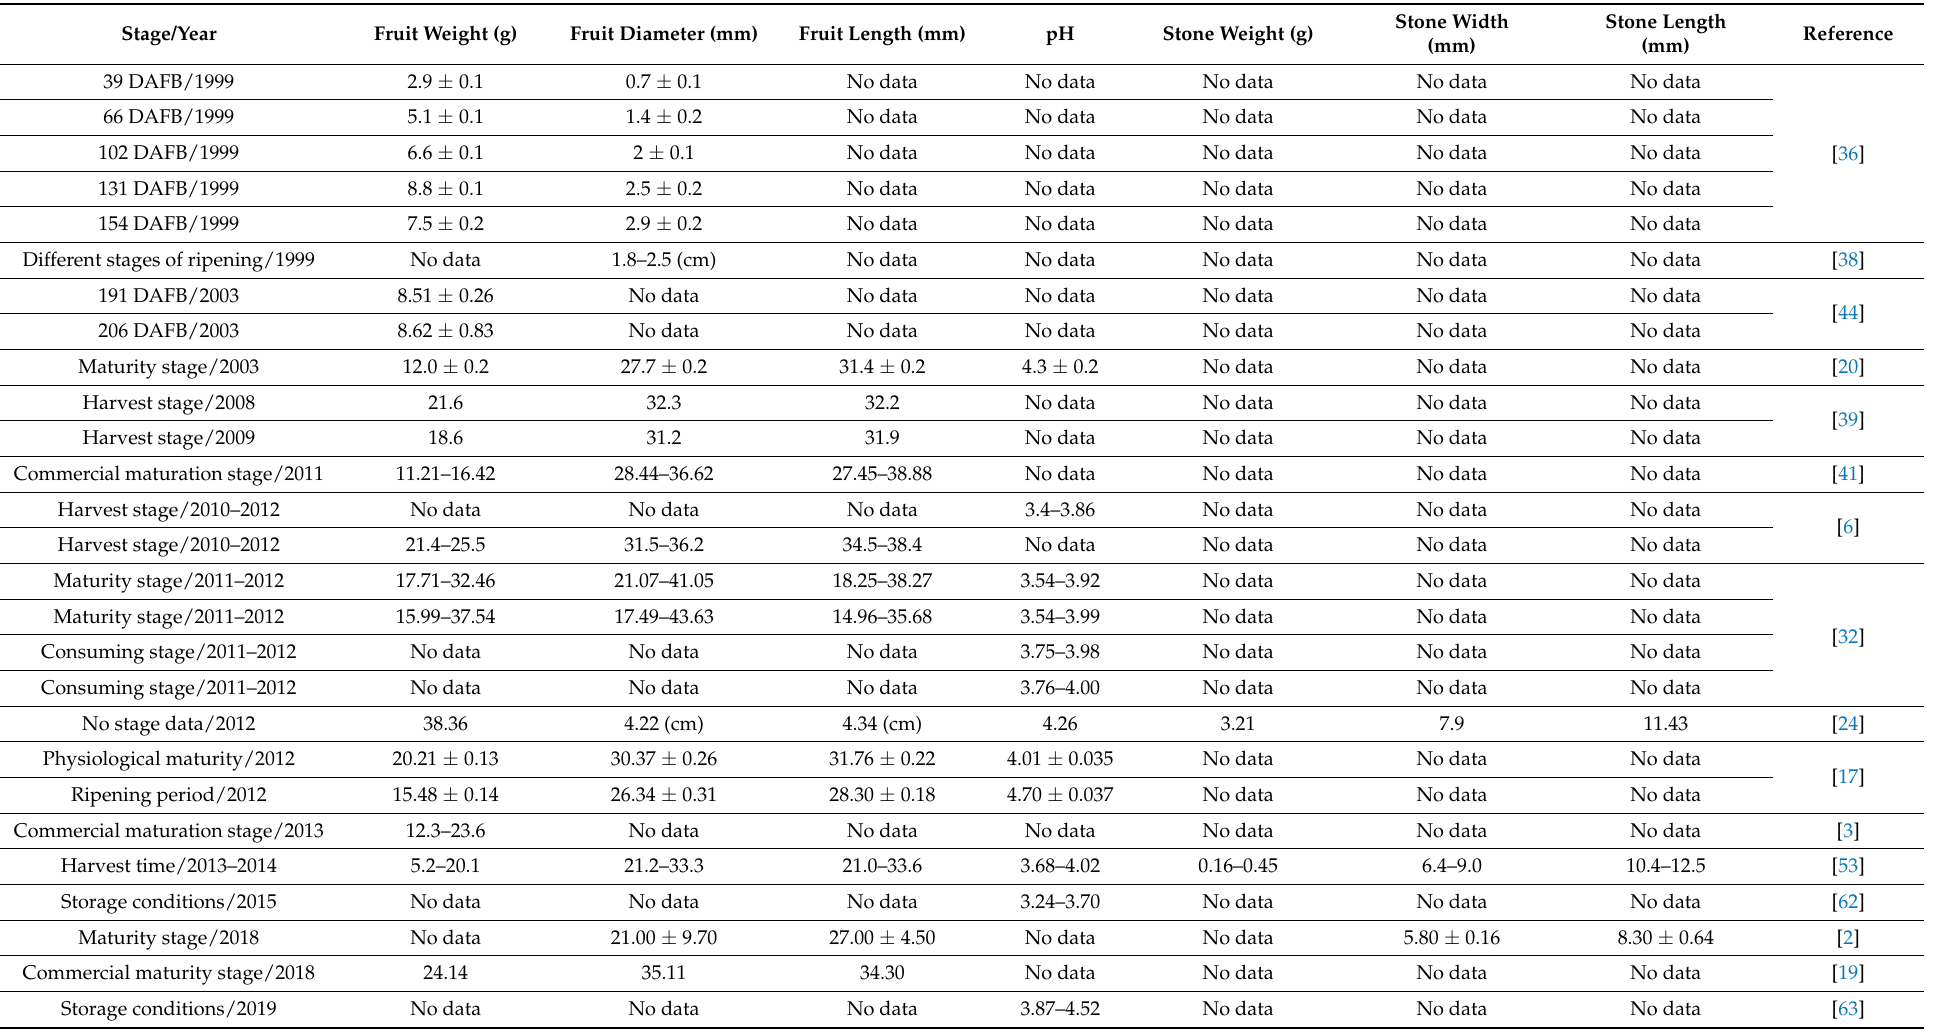
Table 4. Variability of the main morphometric characteristics of Mespilus germanica L. plant parts (fruits and stone) according to the authors from different